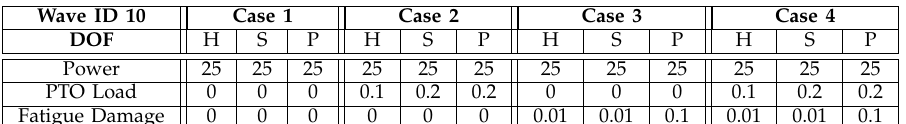
TABLE III: Weight matrix by case for Wave ID